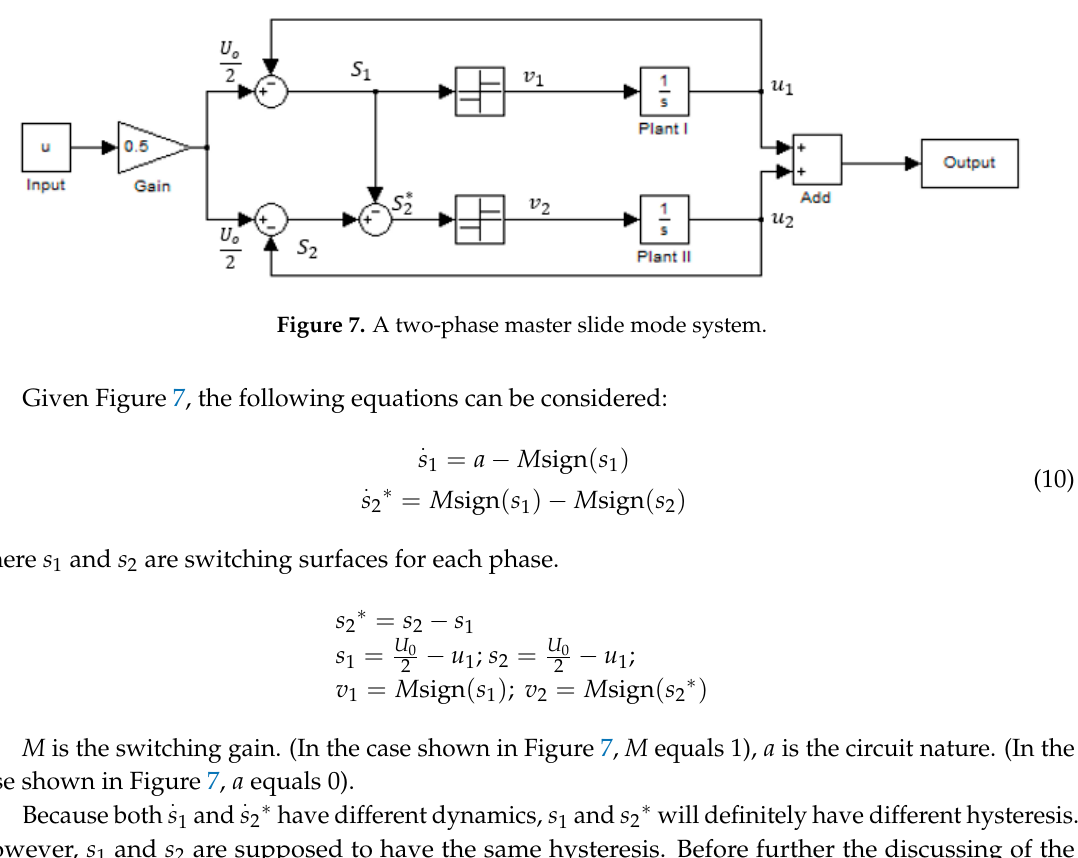
Figure 6. Proof of the convergence of the two-dimension control. The initial condition s k − 1 = 1, s k = 0. The control frequency = 10 kHz.